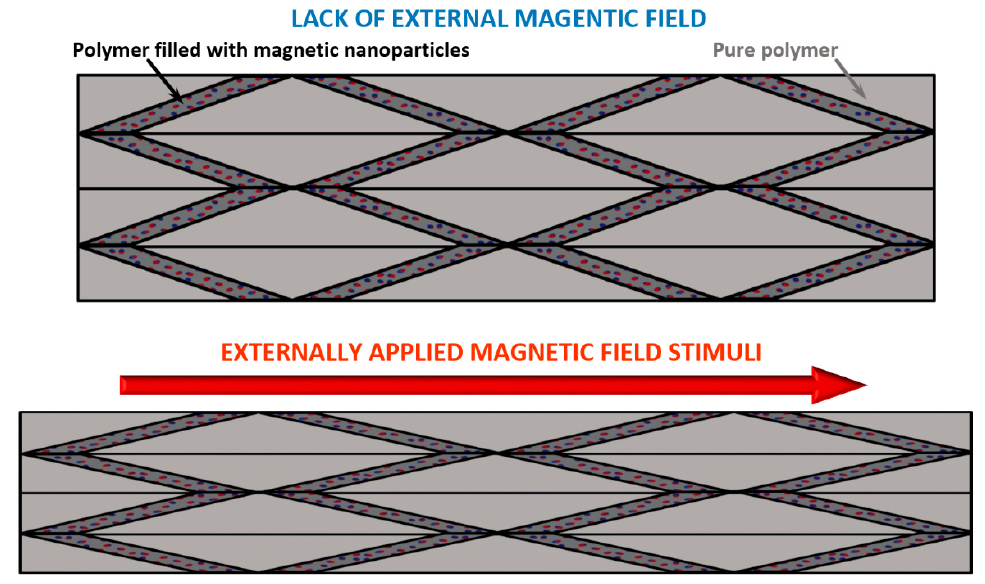
Figure 4. An indicative application of 6D printing. The inclined complex layering by using combinations of pure and nano-reinforced polymeric layers allows intensive response under the action of a magnetic stimulus.